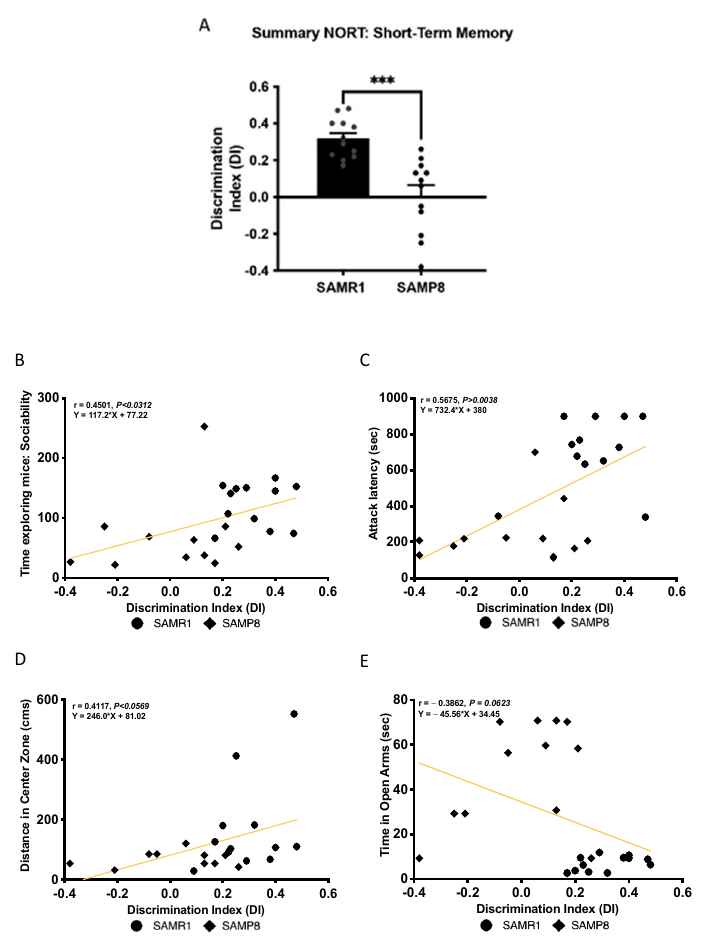
Figure 3. Summary of NORT for short-term memory ( A ). Bars show the mean ± SEM (for NORT: n = 12 mice per group). Statistical test: t-Student analysis. *** p < 0.001. Correlations between the time exploring mice indicating sociability ( B ), attack latency ( C ), distance travelled in the central zone